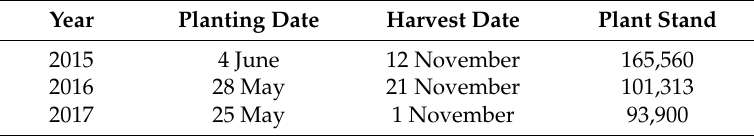
Table 4. Planting and harvest dates and final plant stand (plant ha − 1